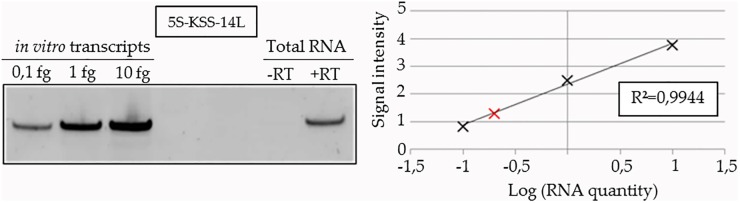
Quantification of 5S-KSS-14L RNA expression by semi-quantitative RT-PCR.On the left, PAGE analysis of the RT-PCR reactions performed on the total cellular RNA or known amounts of purified T7-transcripts, as indicated above the panel. On the right, an example of the calibration curve used for quantification of 5S-KSS-14L RNA (in red) in cybrid cell line.